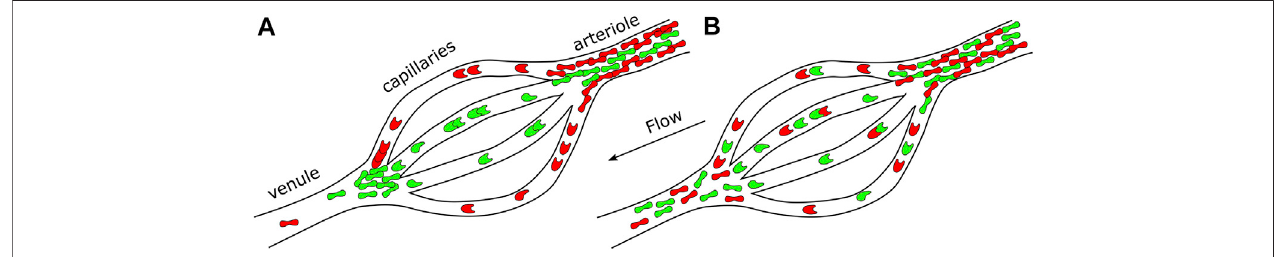
FIGURE 6 | Scheme representing an arteriole, capillaries, and a venule. Possible consequences on the capillaries bed and venule feeding in both (A) heterogeneous sRBC distribution and (B) homogeneous sRBC distribution at the arteriole